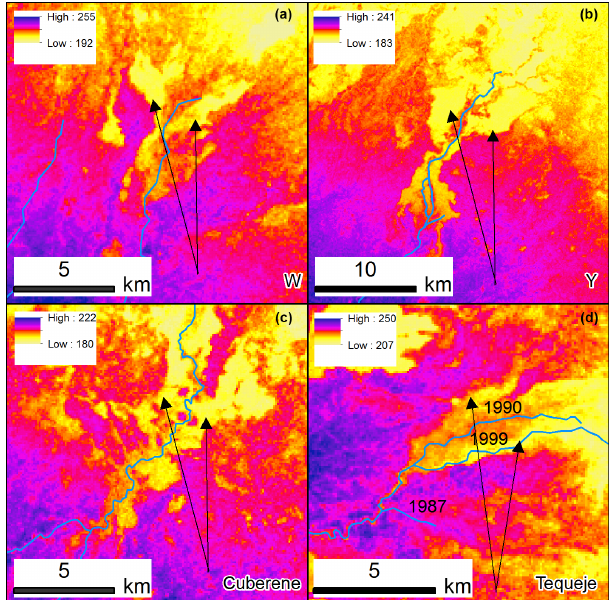
Figure 4. SRTM image of four areas where logjam-induced floods resulted in the death of the forest. SRTM imagery shows the situ- ation, in the year 2000, for the rivers Cuberene, Tequeje, W, and Y. At any given point, the SRTM digital elevation model gives the elevation of the canopy, not the elevation of the soil; therefore, de- forested patches are visible as depressions (here rendered as yellow areas surrounded by red). The arrows indicate the areas where forest has been replaced by herbaceous